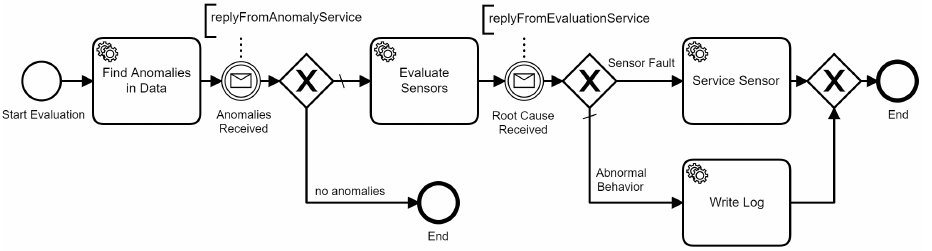
Figure 11. Service orchestration for sensor data